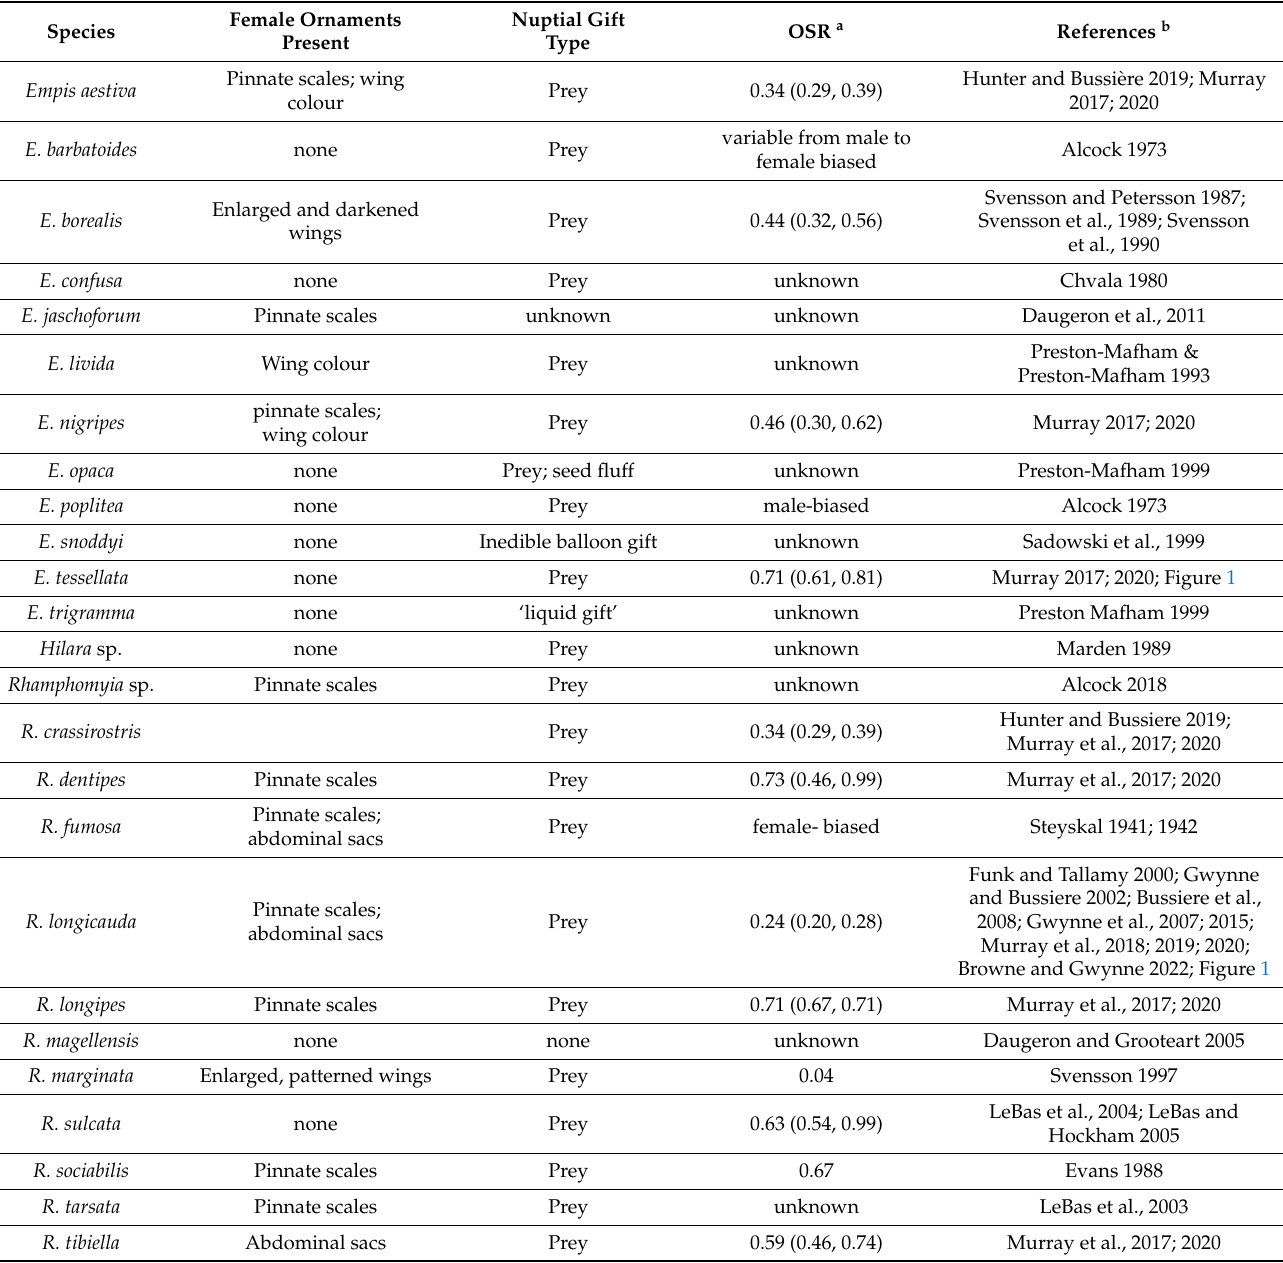
swarms. Table 1 features a summary of some species whose behaviour or morphology has been studied in some detail, alongside references. In most species, females obtain necessary protein for egg development from exogenous (sensu [8]) nuptial gifts of captured prey and, in a few cases, endogenous male glandular products [1,9,10]). Table 1. An alphabetical summary of the Empidinae species discussed in the text with associated descriptions of female ornamentation (when present) and measurements (when available) of be- havioural and mating system